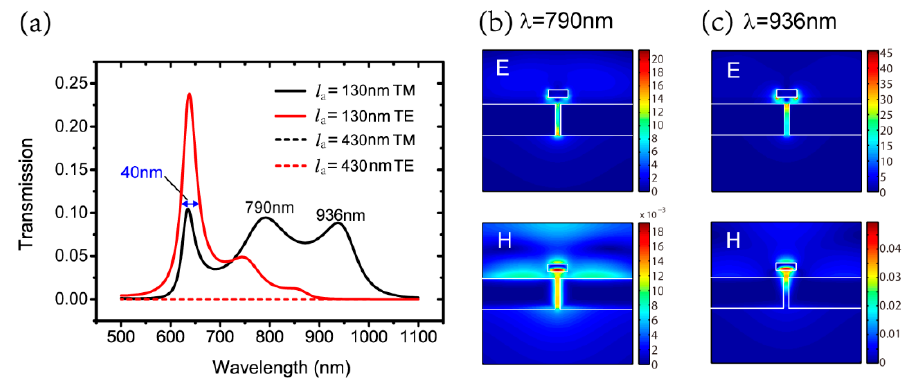
Figure 8. ( a ) Spectral responses of the nano-system with l a = 130 nm and l a = 430 nm for TM and TE polarizations; electric and magnetic field distributions of ( b ) λ = 790 nm and ( c ) λ = 936 nm with l a = 130 nm for TM polarization.